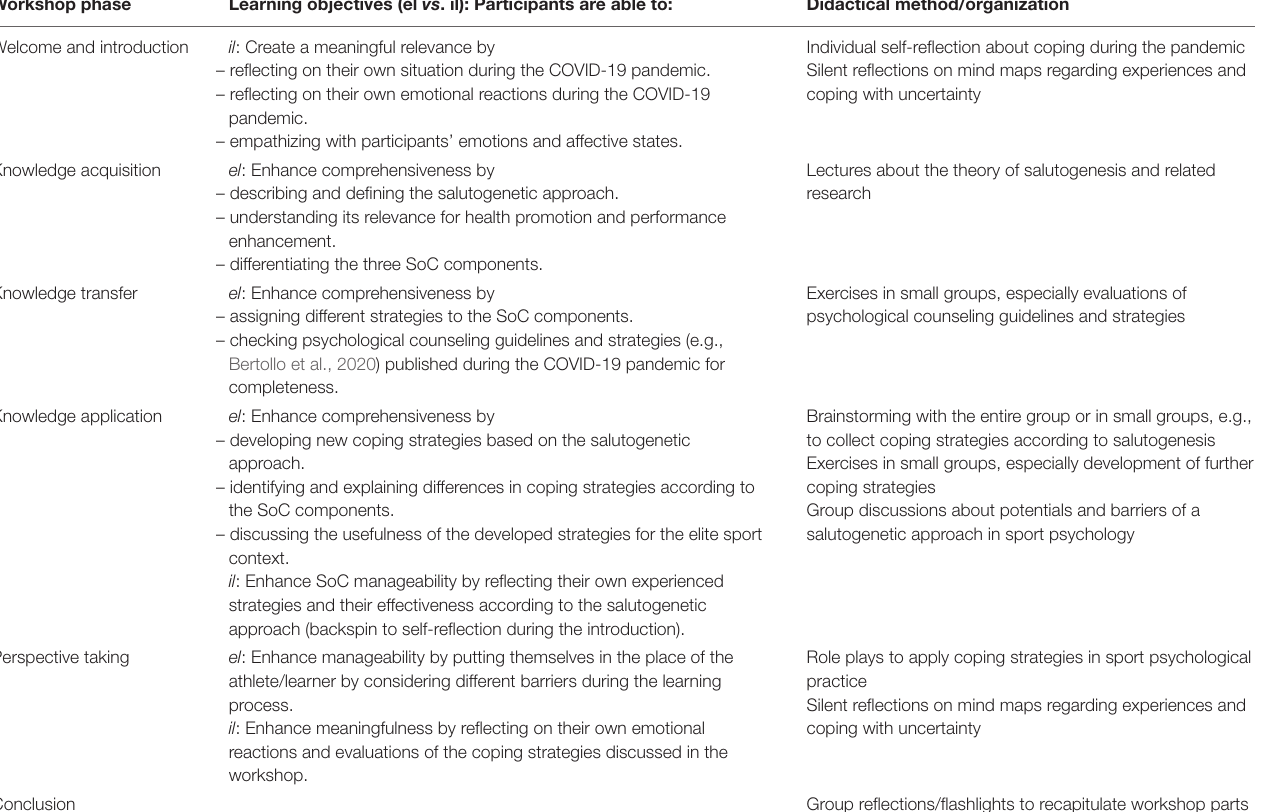
TABLE 2 | Workshop procedure: schedule, learning objectives, content, didactical methods, and material. Workshop phase Learning objectives (el vs . il): Participants are able